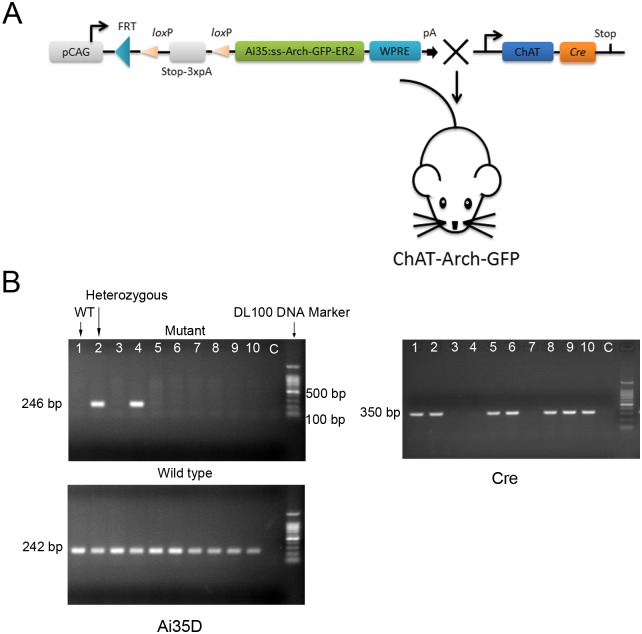
Recombination of Ai35D and ChAT-Cre mice.
(A) Diagram of heterozygous mice with conditional expression of Arch-GFP after recombination of the Stop-loxP gene and ChAT-Cre recombinase. (B) PCR analysis. Ai35D heterozygous mice had one 242-bp and one 246-bp band, while WT mice had only one 242-bp band. The positive Cre band was at 350-bp.